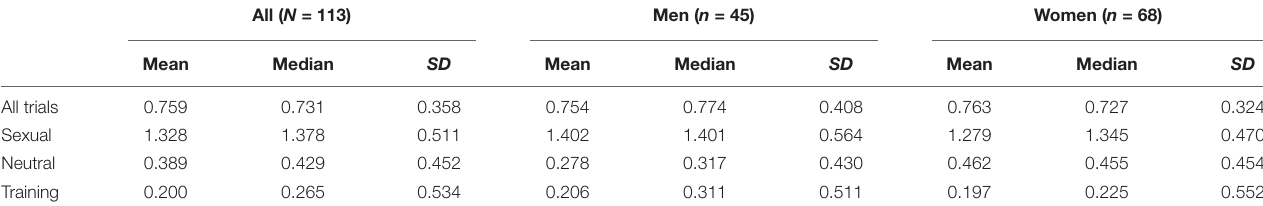
TABLE 4 | Picture recognition task: Mean sensitivity index d’ , median, and SD .